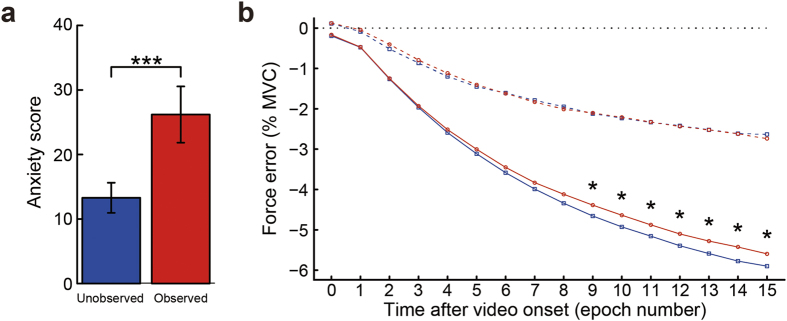
Behavioural results.(a) Mean self-rated anxiety score showing a significant increase in anxiety in the observed condition. (b) Mean force error. Force error data for each 1-s period of social video presentation were averaged across trials and participants for each condition. During the 10% MVC task isometric grip force was significantly increased in the observed (red solid line) compared to unobserved condition (blue solid line). However, during the 5% MVC task force level did not significantly differ between the observed (red dashed line) and unobserved (blue dashed line) conditions at the group level. Data are represented as mean ± SEM. ***p < 0.001, *p < 0.05.